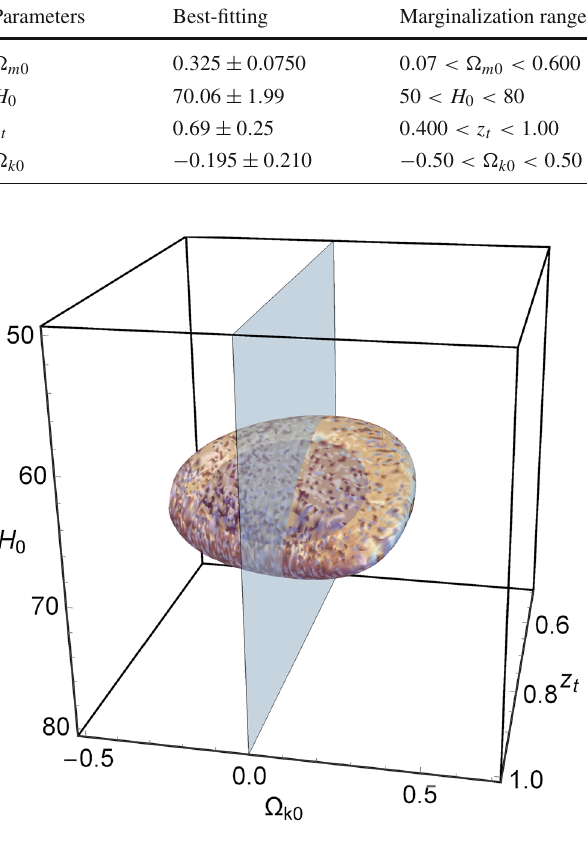
Fig. 6 The 1 σ - 2 σ confidence contour of the parameters space ( z ,(cid:5) , H ) using the joint analysis t k 0 0